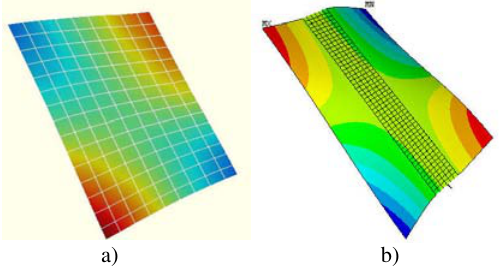
Fig 9. Mode shape for the first eigenfrequency